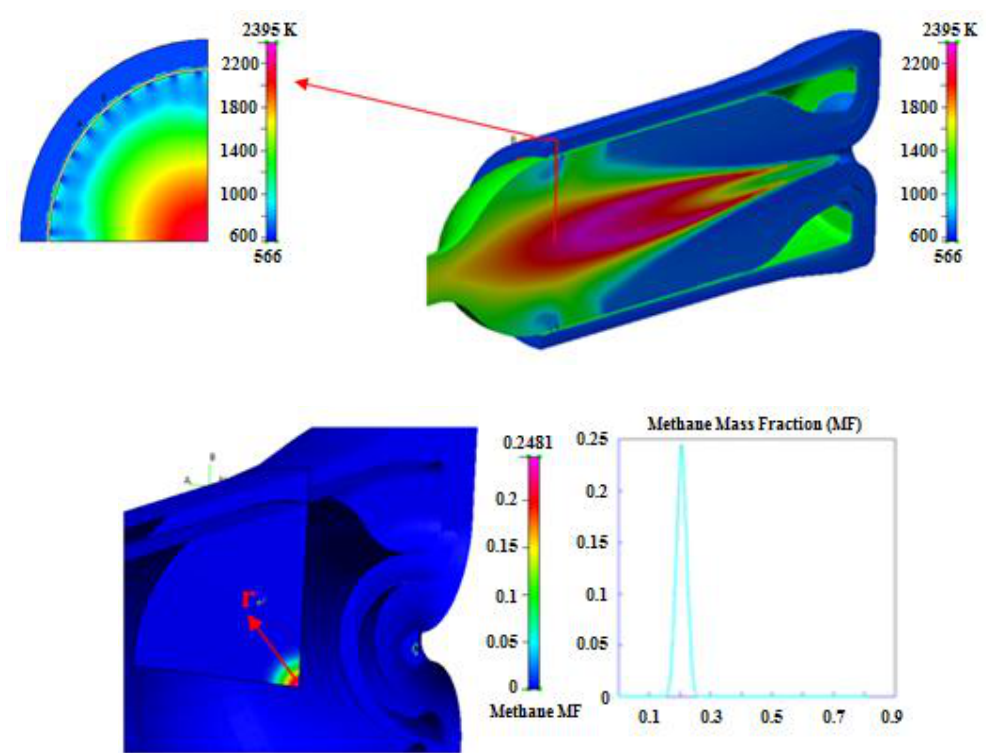
Figure 7. ( a ) Temperature contour plot for a secondary zone cross-section ( Left ) and the symmetry plane ( Right ); ( b ) Methane concentration within the primary